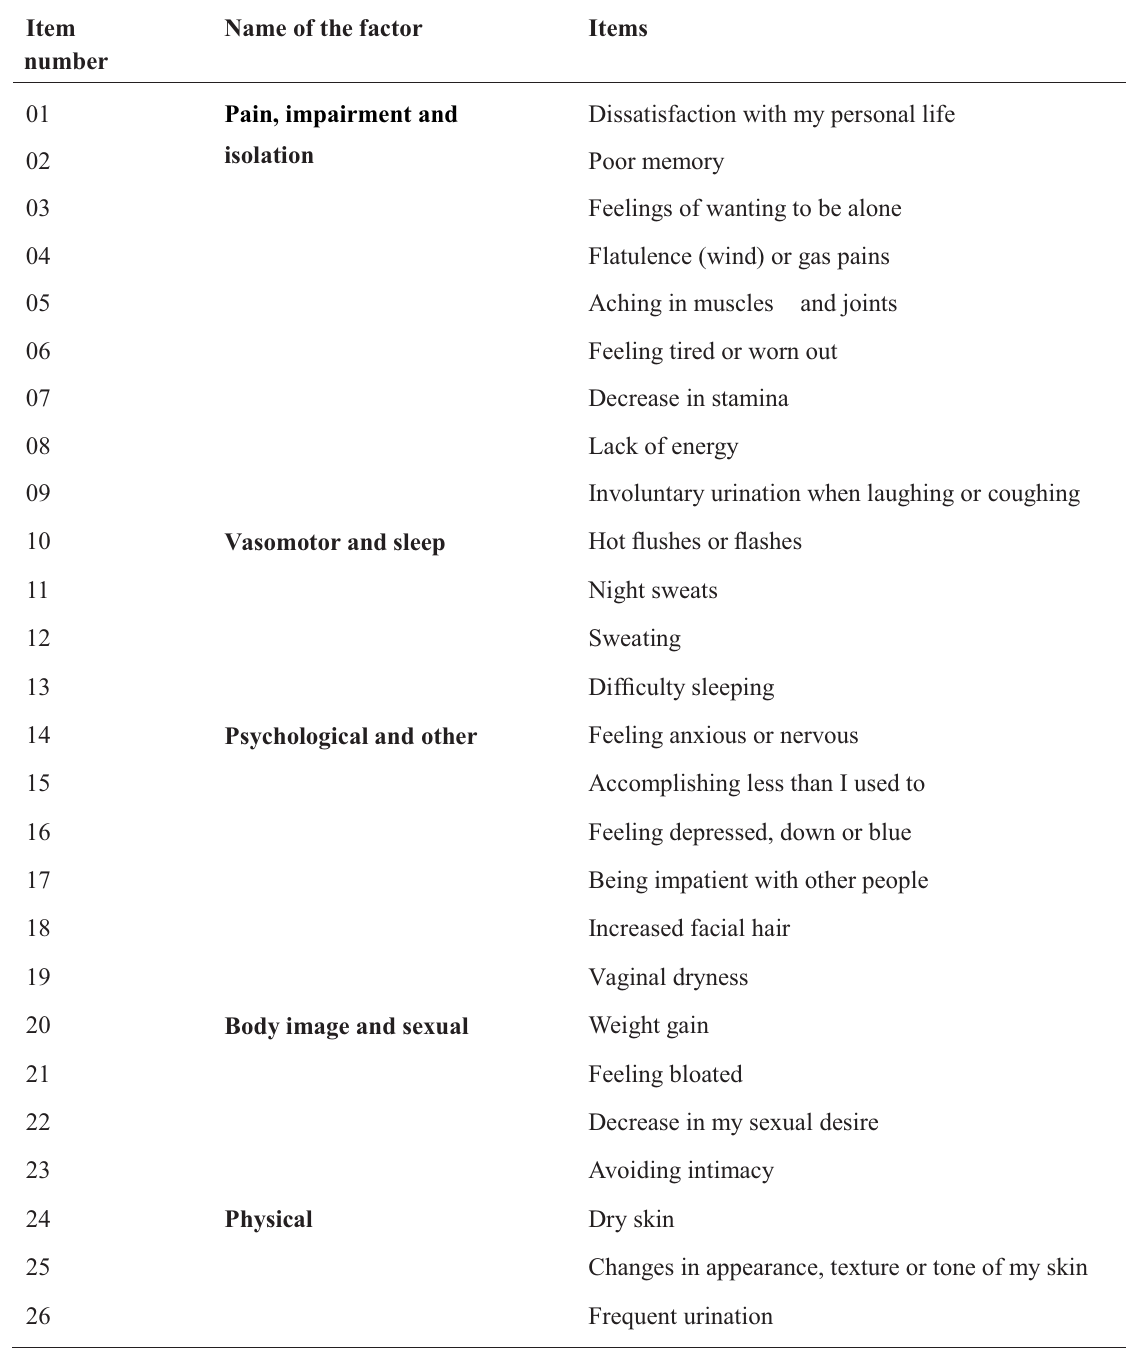
Table 3: MENQOL-S domains and the number of items under each domain after EFA